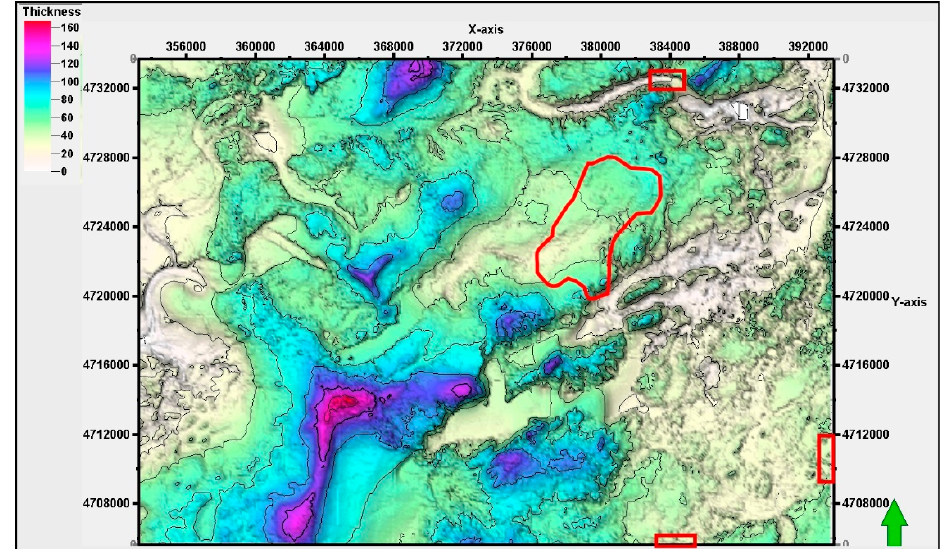
Figure 15. Map of depth to bedrock in the study area. The red polygons outline areas where the STSG, SWSG, and bedrock are modeled to be in contact with each other. The green arrow points north. Thickness is in meters.